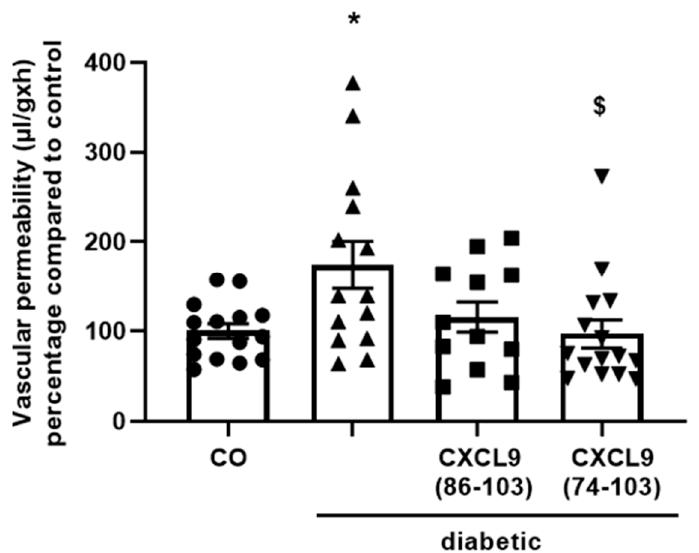
Figure 9. CXCL9(74-103) reduces vascular permeability in diabetes-induced rats. After induction of diabetes in rats, the vitreous of the right eye was injected with equimolar amounts of CXCL9(74-103) (30 µ g), CXCL9(86-103) (18 µ g) or PBS. After two weeks, the retinas were excised and the vascular leakage was assessed using FITC-labeled dextran i.v. injected prior to sacrifice. Vascular permeability ( µ L/g × h) [mean ( ± SEM)] is depicted compared to control rats. [Mann–Whitney U test; * p < 0.05 (compared to control rats); $ p < 0.05 (compared to diabetic rats); CO rats: n = 15, diabetic rats: n = 14, CXCL9(86-103)-treated diabetic rats: n = 12, CXCL9(74-103)-treated diabetic rats: n = 15; the experiment was repeated three